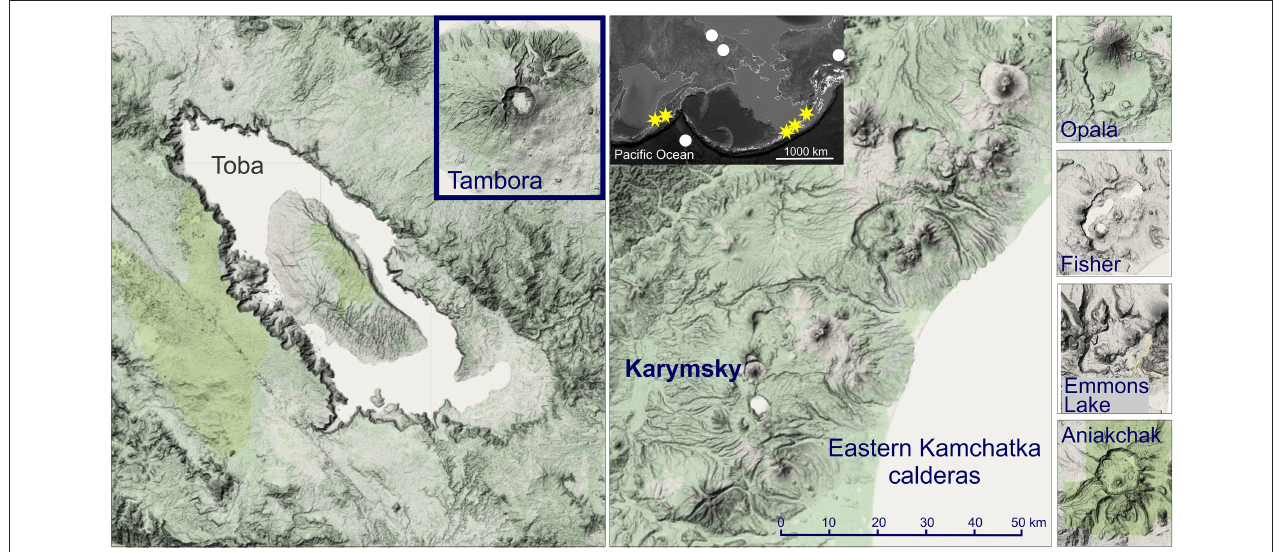
FIGURE 1 | Selected calderas of the North Pacific volcanic arcs in comparison with Toba and Tambora. The Kuril-Kamchatka and Alaska-Aleutian volcanic arcs host more than forty large (5–20km) Quaternary calderas, many of those are nested. Tephra volumes for most of them were estimated based only on proximal deposits. Only a few tephras related to these caldera-forming eruptions have been mapped (e.g., Kurile Lake, Ponomareva et al., 2004; Old Crow, Preece et al., 2011), and only one (Aniakchak) has been identified as cryptotephra beyond the North Pacific region (Coulter et al., 2012; Pyne-O’Donnell et al., 2012). In the eastern Kamchatka, closely spaced calderas are surrounded by a complex multi-unit ignimbrite sheet. Inset shows locations of the North Pacific calderas presented in the Figure and the sites mentioned in the text. Calderas (yellow stars; from west to east): Opala, Karymsky, Fisher, Emmons Lake, Aniakchak. Sites (white